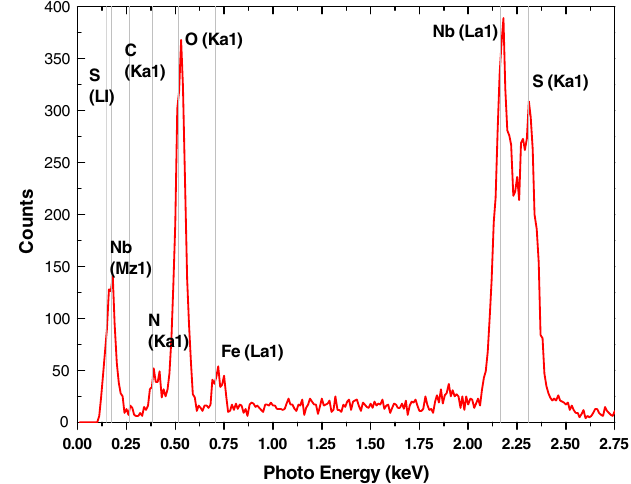
FIG. 14. EDX spectrum surveyed from the yellow box (Fig. 13). It contains S, Fe, and N elements besides Nb and O. The origin of Fe and N are unknown. The elemental ratio of N, O, S, Fe, and Nb is 19:72:5:3:1 after commercial EDAX software